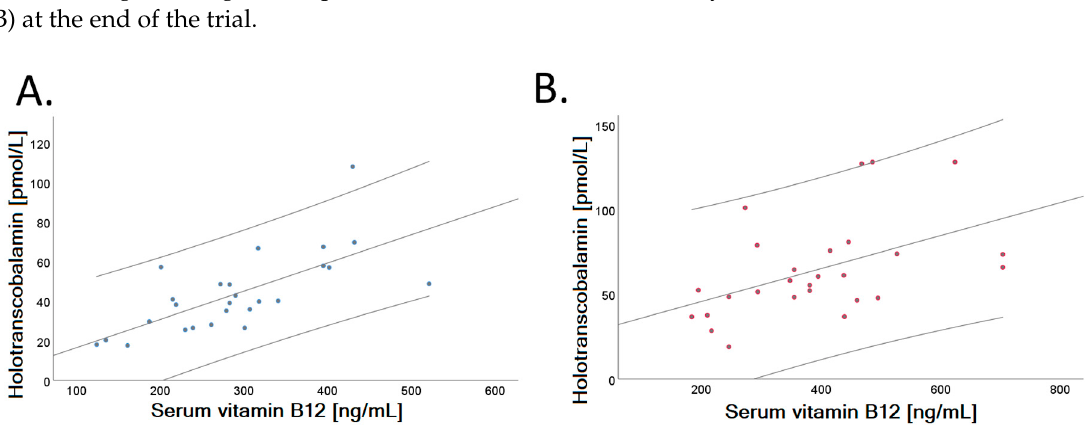
Figure 4. Relationship of serum holotranscobalamin and vitamin B 12 in the two randomized groups after a 4-week dietary intervention. Vitamin B 12 (ng / L) correlates positively with holotranscobalamin concentration (pmol / L) both after intervention in VD (Panel A , r = 0.695, p < 0.001) and in MD (Panel B , r = 0.484, p = 0.010). Dispersion lines show the 95% confidence interval of the linear regression fit. Baseline and end values of MMA (Table 2 and Figure 3, Panel B) as well as of tHcy (Table 3 and Figure 5, Panel D) did not di ff er significantly between the groups. Table 3. Amino acids associated with homocysteine metabolism measured in serum of the subjects in the vegan and meat-rich diet group after four weeks of intervention. SD = Standard deviation; p -value (baselines) indicates comparison of values at baseline (results from t -test or MWU-test). p -value (end) indicates comparisons at the end of the study adjusted for baseline values (results from ANCOVA). p -value (baseline-to-end) indicates comparisons of changes from baseline to end of study (results from mixed ANOVA). Statistically significant results are